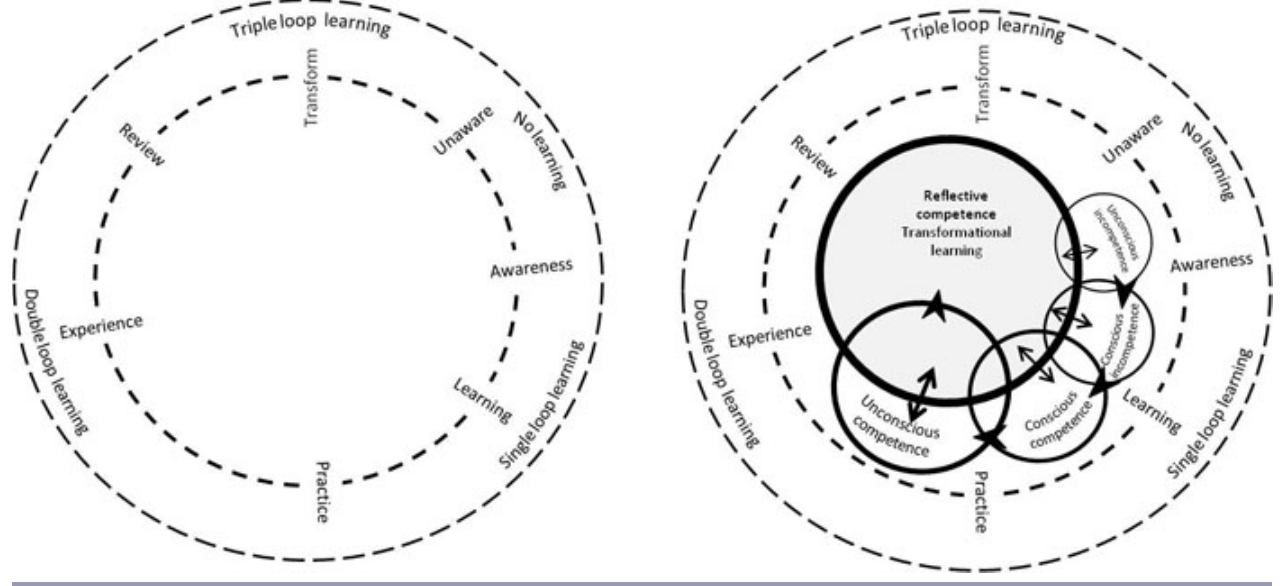
Fig. 1. An integrated framework for the complex stages and processes of learning and adopting new knowledge, skills, or frame of reference. The first step for anyone is becoming aware of the need to learn. This learning must proceed through practice and review from single- to double- to triple-loop learning (left-hand diagram). Changing levels of consciousness and reflection then lead to deeper learning that can change one’s frame of reference. The framework (right-hand diagram) presents a number of stages along the path to a mature understanding and reflection that continually challenges one’s path of selective exposure. Unlearning happens during, or as a consequence of, repeated incursions into reflective mode and back again (Modified from Taylor (2007, in Chapman